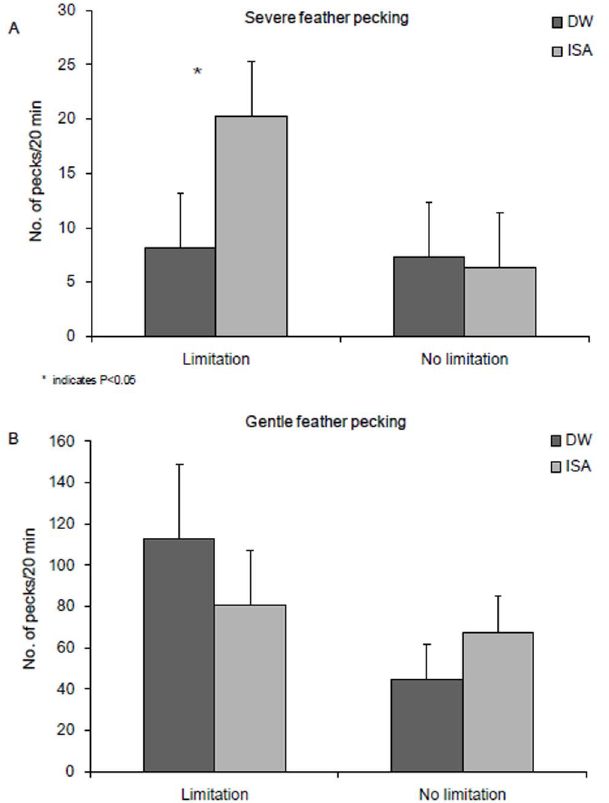
Figure 4. A. Severe feather pecking at 5 weeks of age in Dekalb White (DW) and ISA brown (ISA) birds in relation to litter limitation B. Gentle feather pecking at 5 weeks of age in Dekalb White (DW) and ISA brown (ISA) birds in relation to litter limitation.